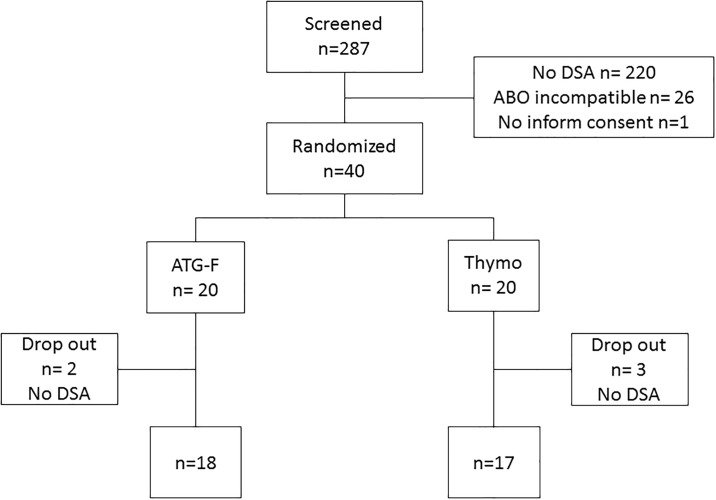
Patient Flow Chart.